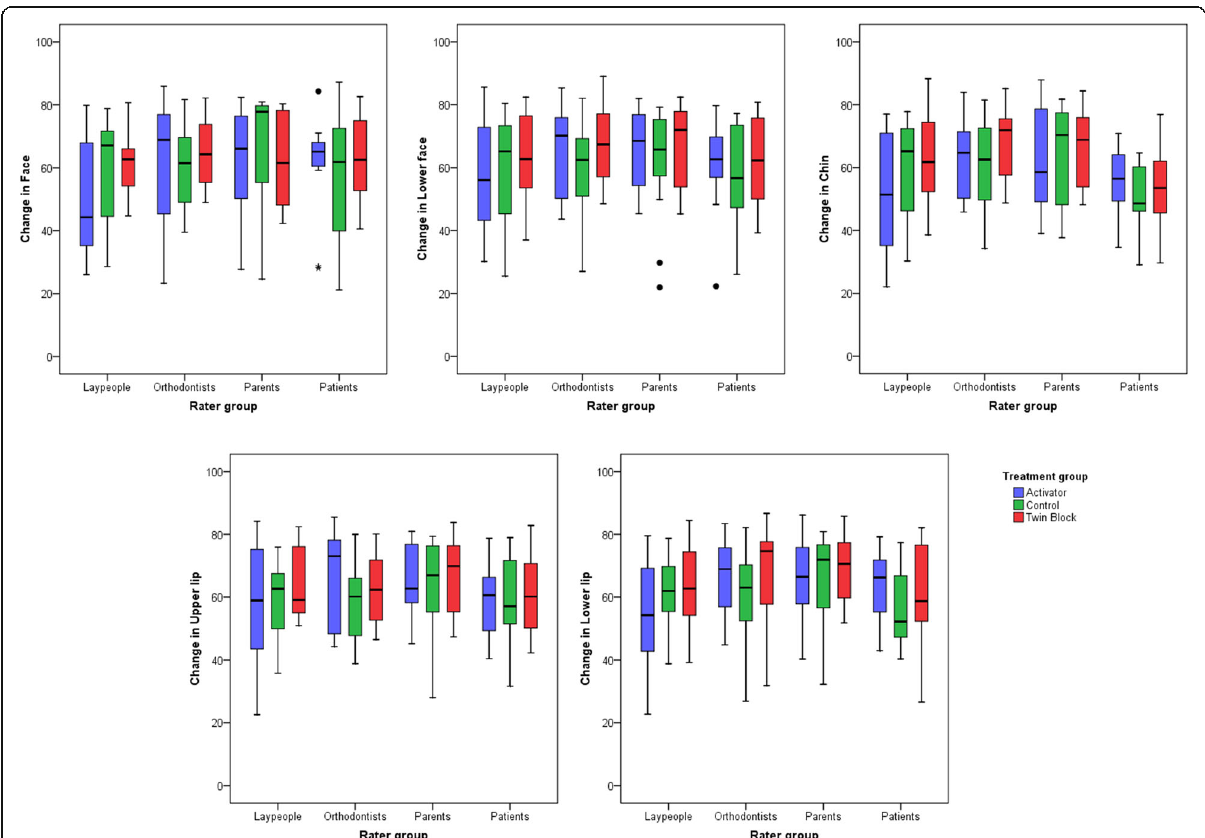
Fig. 4 Box plots showing the assessed changes from pre- to post-treatment condition in VAS values ( y -axis), grouped by rater type. The upper limit of the black line represents the maximum value, the lower limit the minimum value, the boxed the interquartile range, and the horizontal black line the median value. Outliers (> ± 3SD) are shown as black